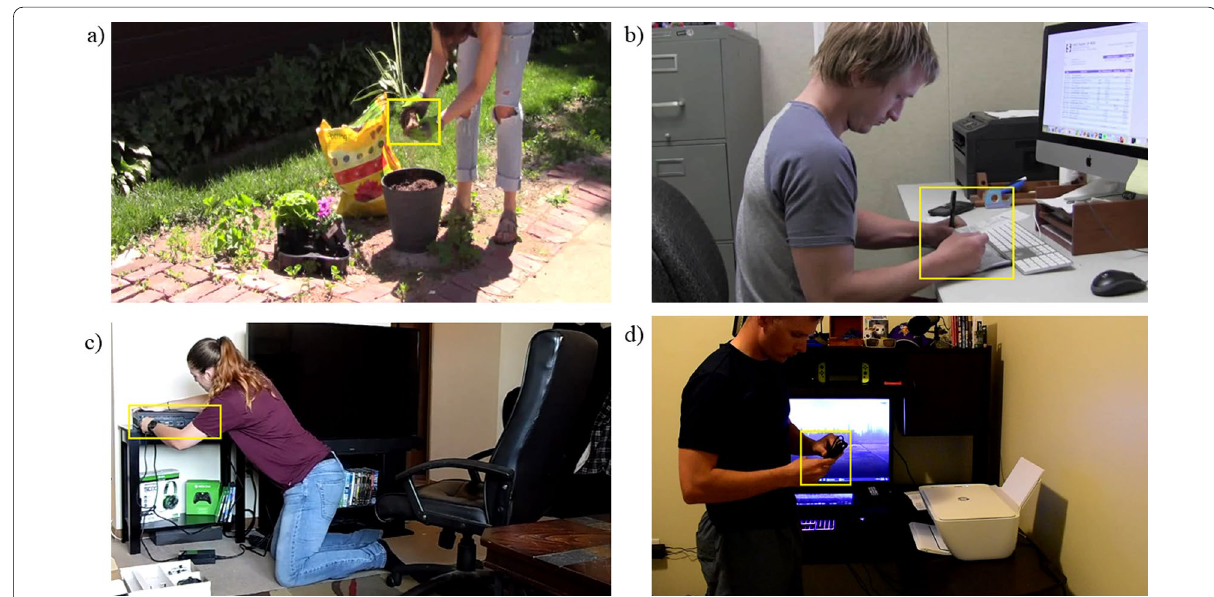
Fig. 1 Event stimuli. Stills taken from each of the four experimental movies: a planting flowers, b balancing a checkbook, c setting up a game console, d installing a printer. The yellow box represents the interest area, which was drawn around the objects in the focus of the actor’s attention. These objects are critical for completion of the current goal. Participants did not see the yellow box while watching the videos. The size of the interest areas was controlled for in the eye movement